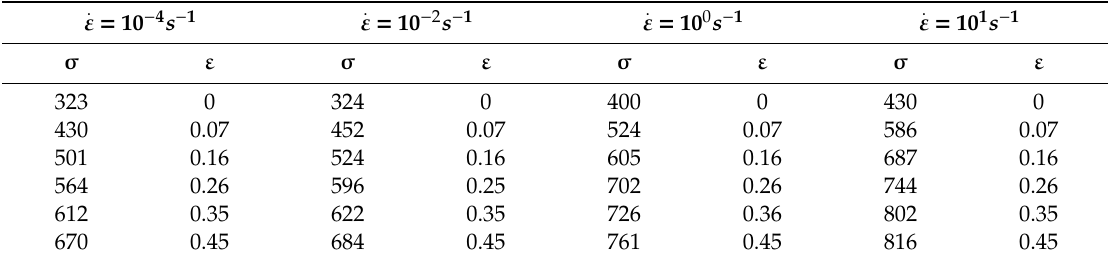
Table 2. Deformation resistance parameters of cold-rolling cracking.